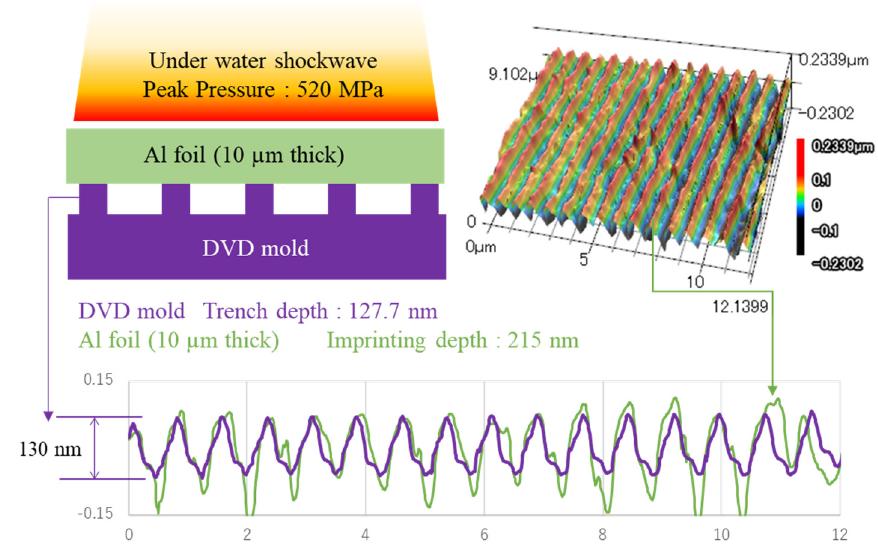
Figure 1. Imprint experiment: an Al foil was compressed into a DVD mold by an underwater shock wave derived from an explosive, yielding a deeper imprinting shape than the DVD mold.